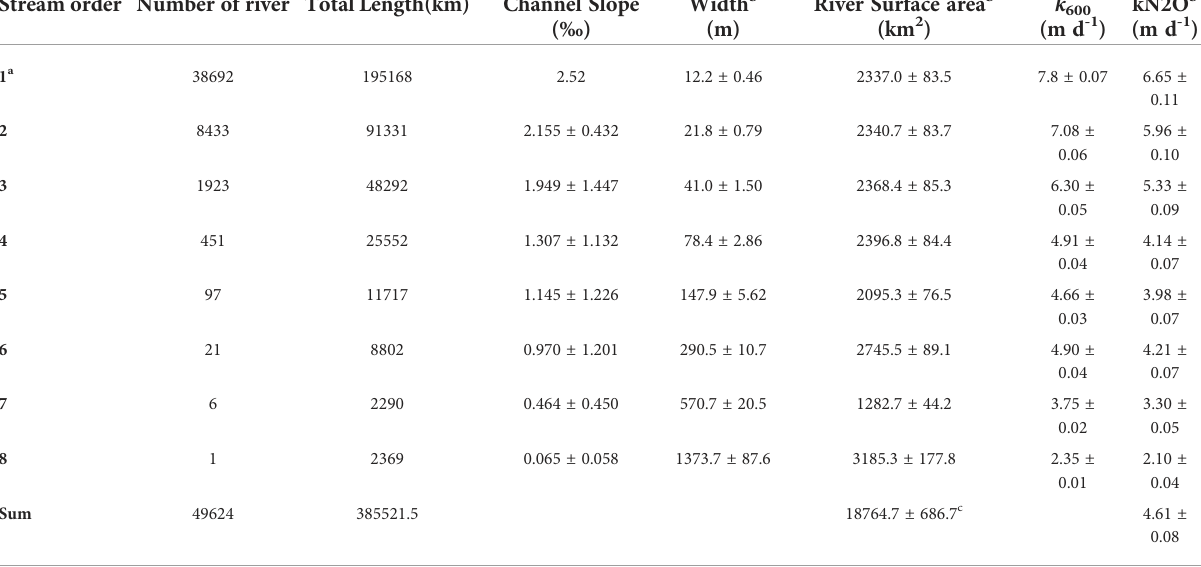
TABLE 1 Statistics for streams and rivers of Changjiang River Basin. Stream order Number of river Total